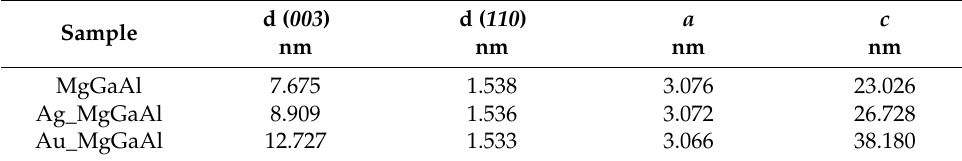
Table 1. The XRD structural characteristics of the MgGaAl based